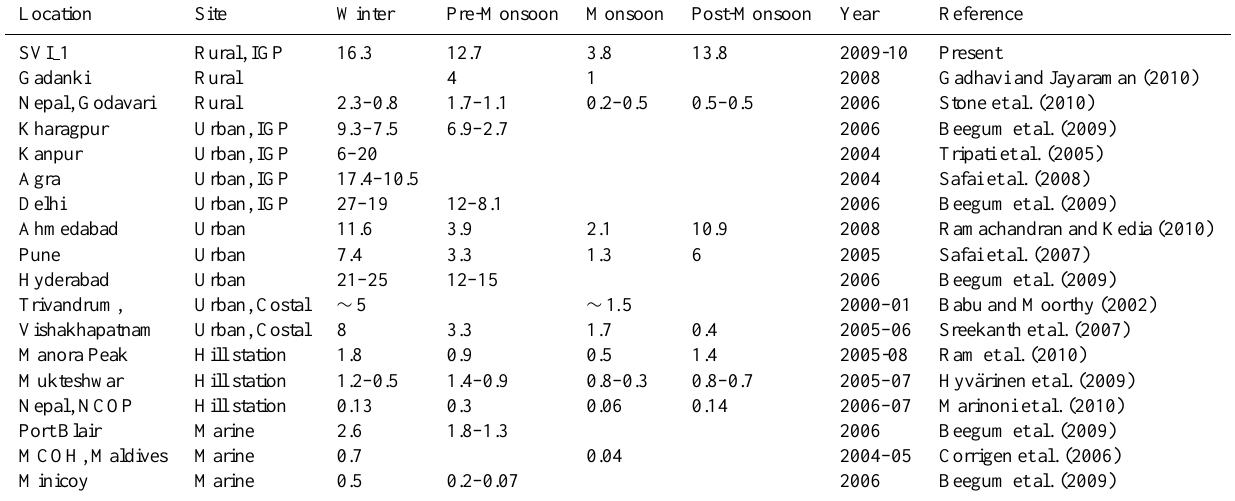
Table 1. Comparison of SVI 1 BC concentration (µgm − 3 ) with earlier reported BC concentration (µgm − 3 ) at different locations in India.